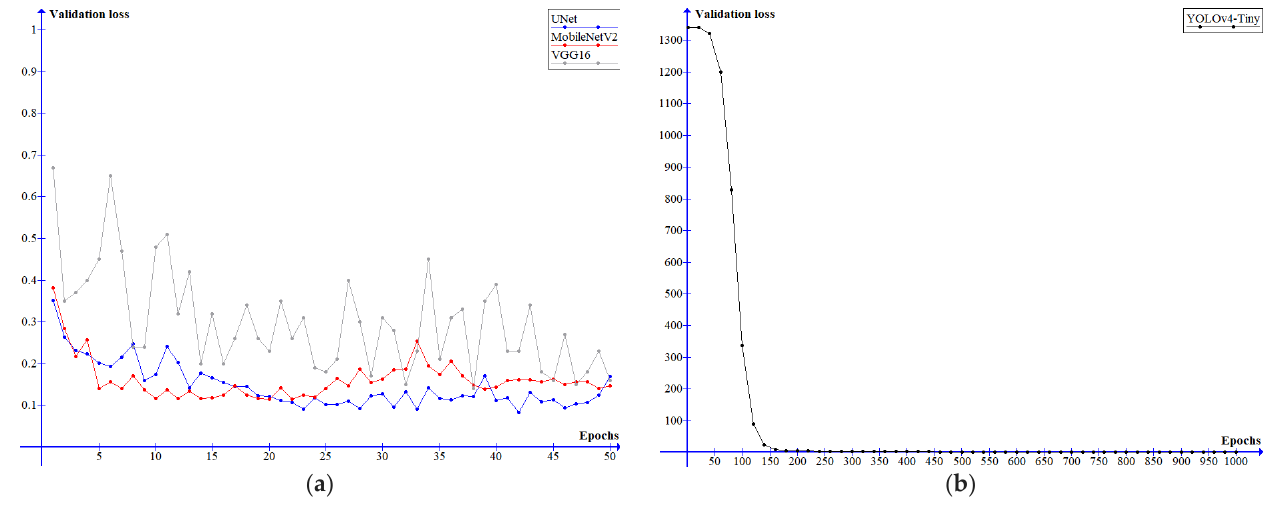
Figure 9. Change in the loss-function: ( a ) UNet, MobileNetV2, VGG16; ( b ) YOLOv4-tiny. The results for the trained networks are shown in Figure 10.